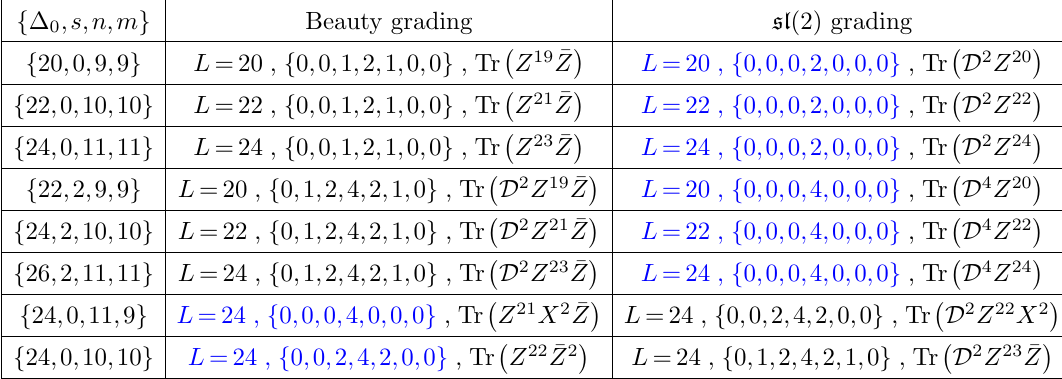
Figure 12 . sl (2) grading, the middle node realizes the non-compact sl (2) sector, the momentum carrying roots u j are exactly the same as in the Beauty grading. The wing roots v ( a ) general di(cid:11)erent in number and value with respect to the Beauty wings ~ v a and w (1) j